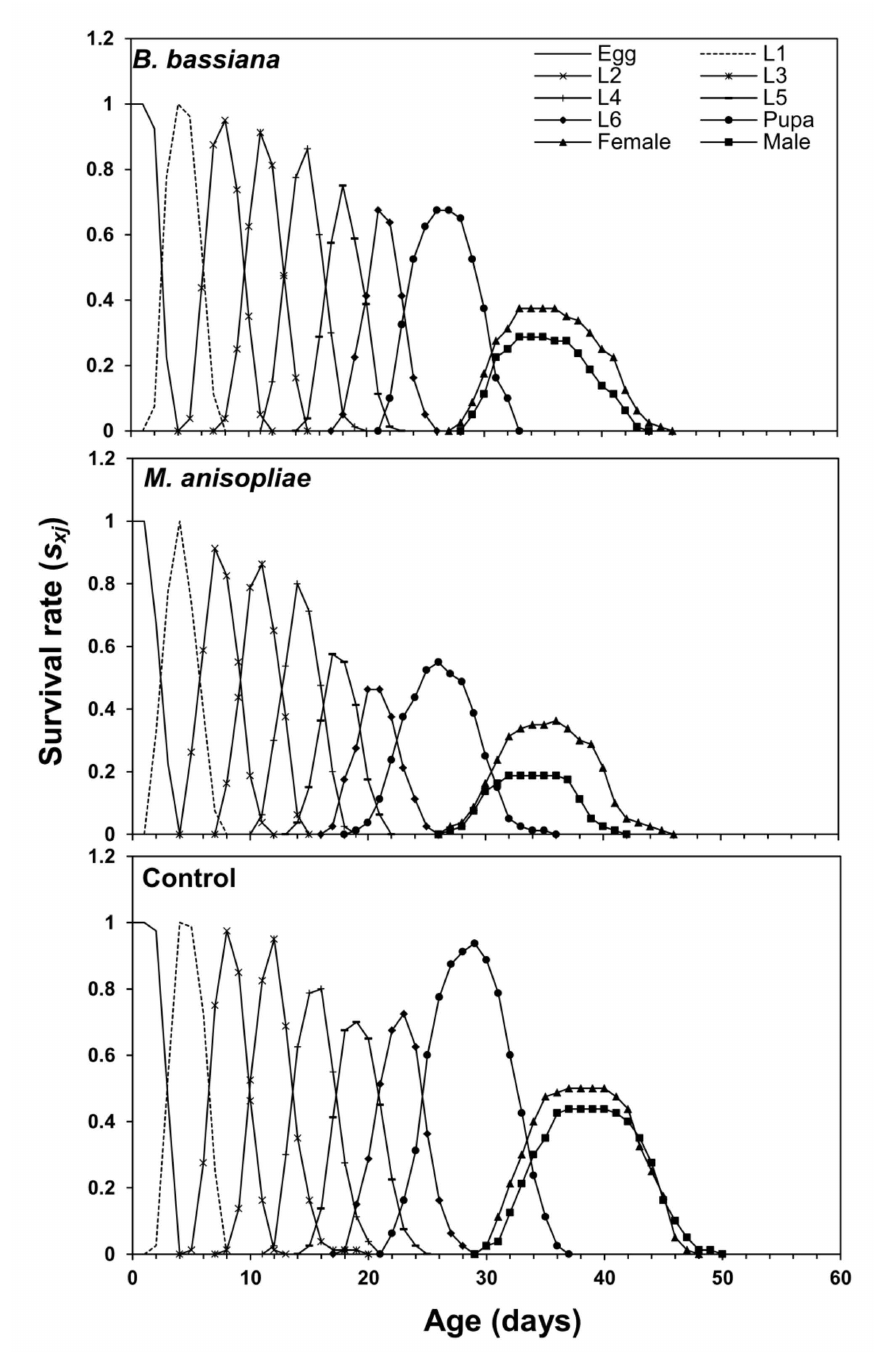
Figure 2. Age-stage-specific survival rate ( s xj ) of Spodoptera frugiperda fed on endophytic colonized and non-colonized